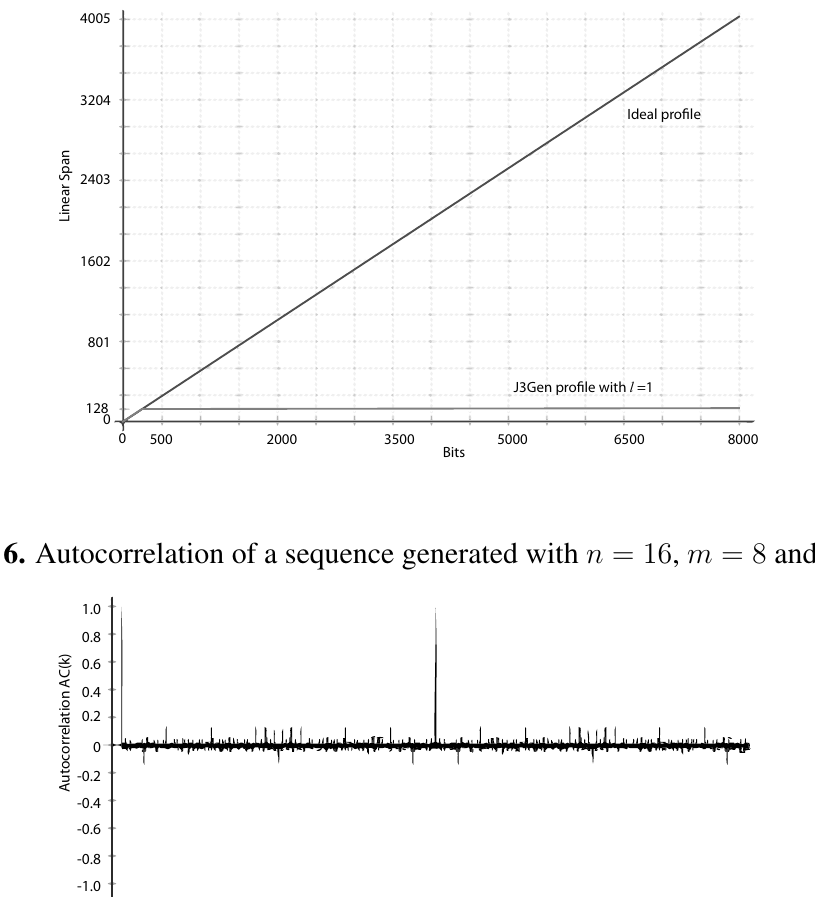
Figure 5. The linear span profile of the first 8,000 bits in a sequence of a length of 30,016 bits produced by the J3Gen PRNG with n = 16 , m = 8 and l = 15 .